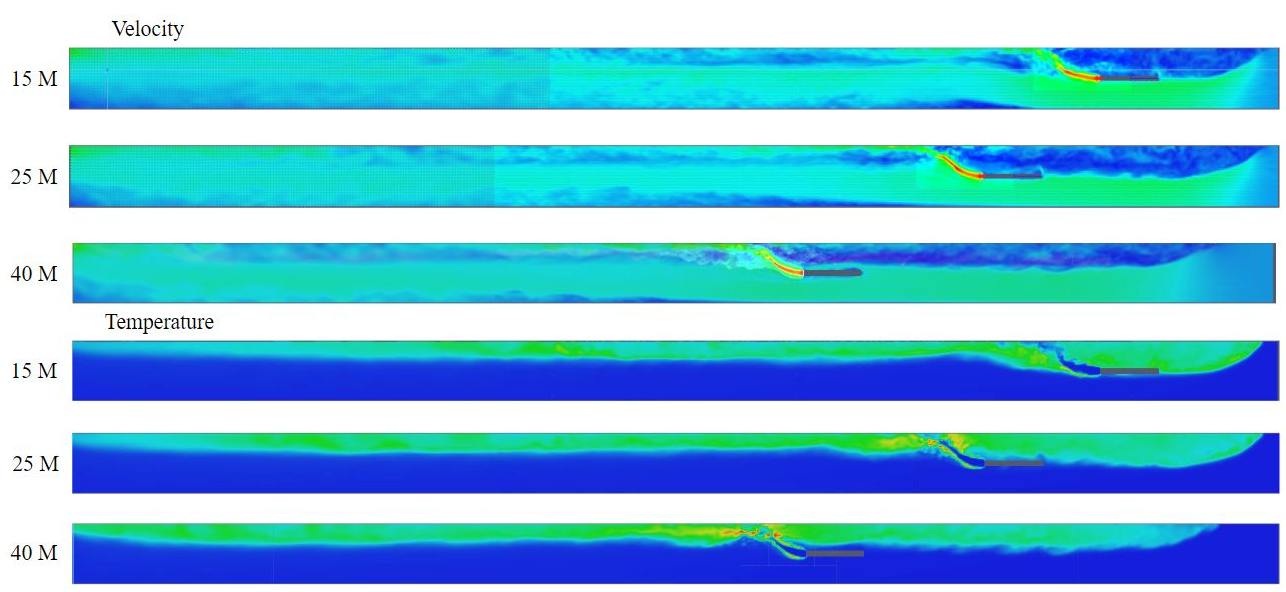
Figure 8. 2D temperature and velocity contour plots at 45 s–effect of the fire source location (Cases 2, 3, and 4). The colour code is the same as in Figure 6.